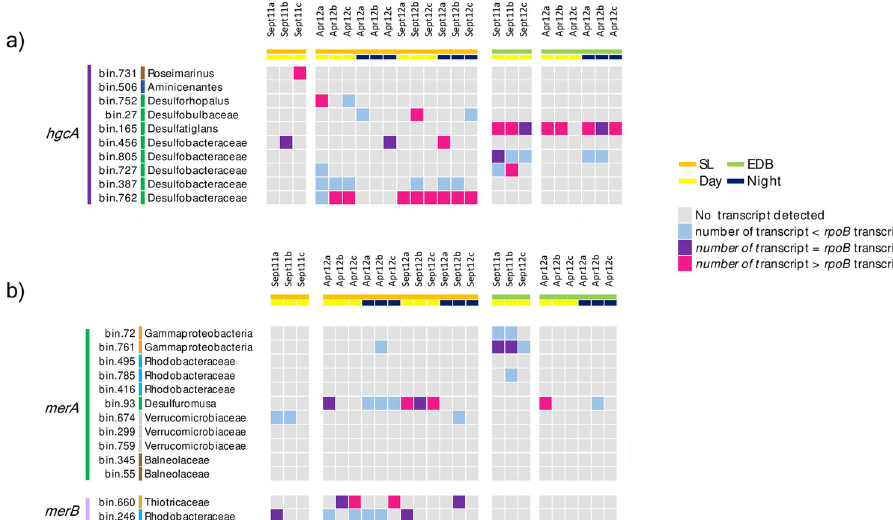
Fig. 6 Expression pro fi les of a hgcA , b merA and merB genes over time in the genomic bins. Expression level was compared to the expression level of rpoB identi fi ed in each bin. Genomic bins are color coded as in other fi